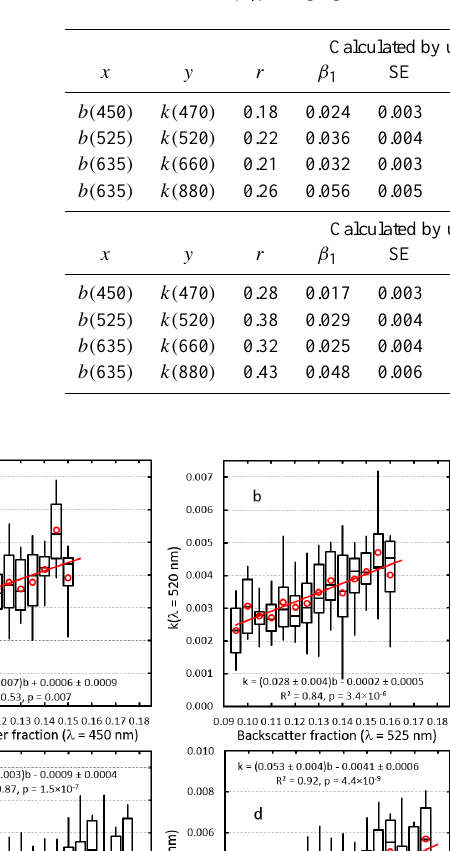
Table 1. Regression statistics ( y = β 1 x + β 0 ) of compensation parameter vs. backscatter fraction. SE: standard error of β 1 ; 95% confidence range of β 1 ; d.f.: degrees of freedom; t = β 1 / SE; p : p value of the Student’s t distribution.